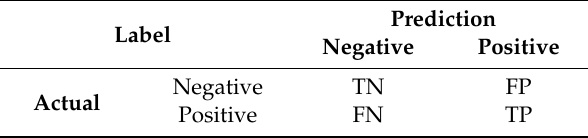
Table 6. The relevant parameters.